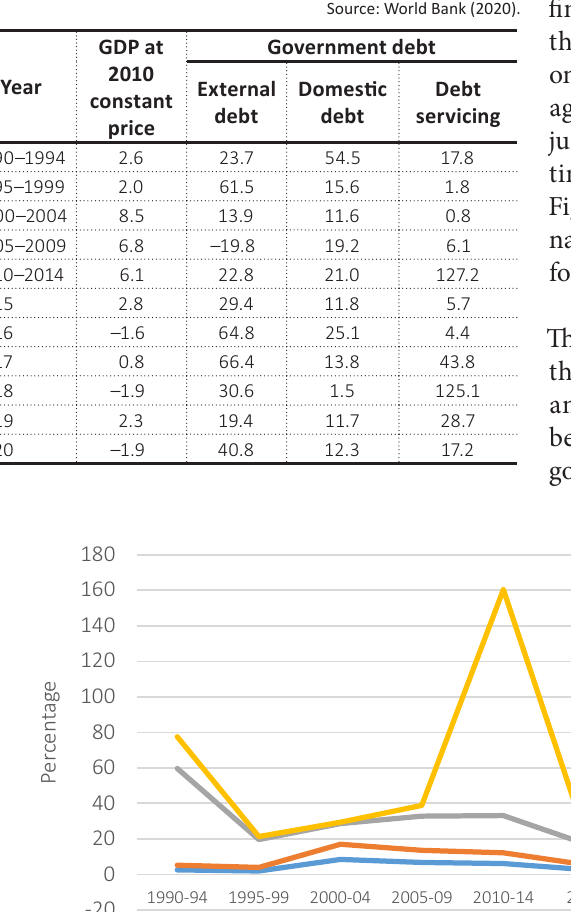
Table 1. Structure of economic growth and government debt in Nigeria, 1990–2020 (%)